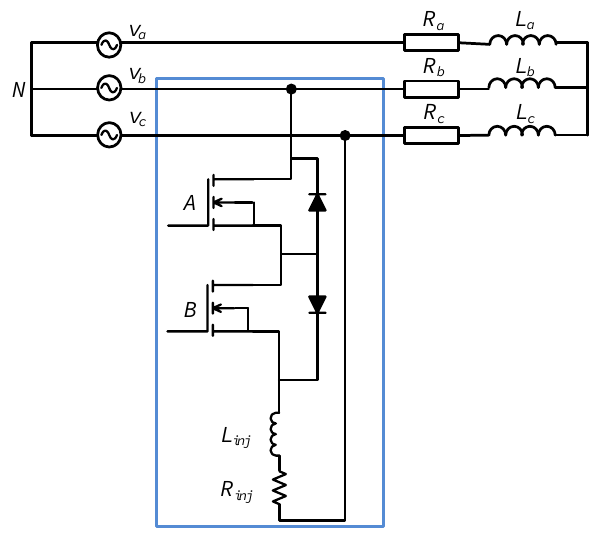
Figure 3. Three-phase alternating current (AC)–AC network’s impedance measurement set-up.